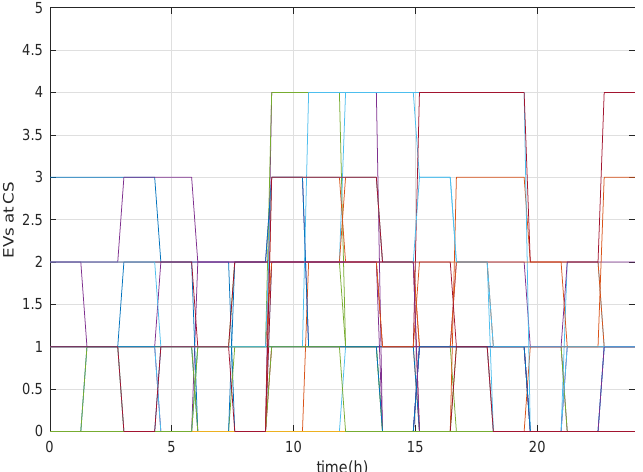
Figure 2. Sample of a Charging station occupation for one